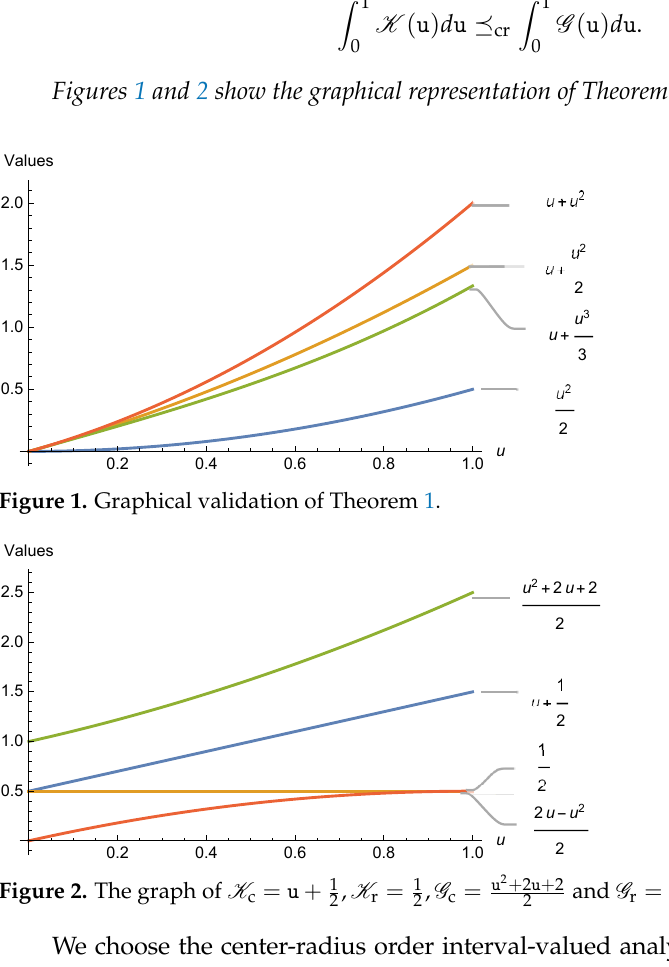
, K r = 1 , G c = u 2 + 2 u + 2 2 2